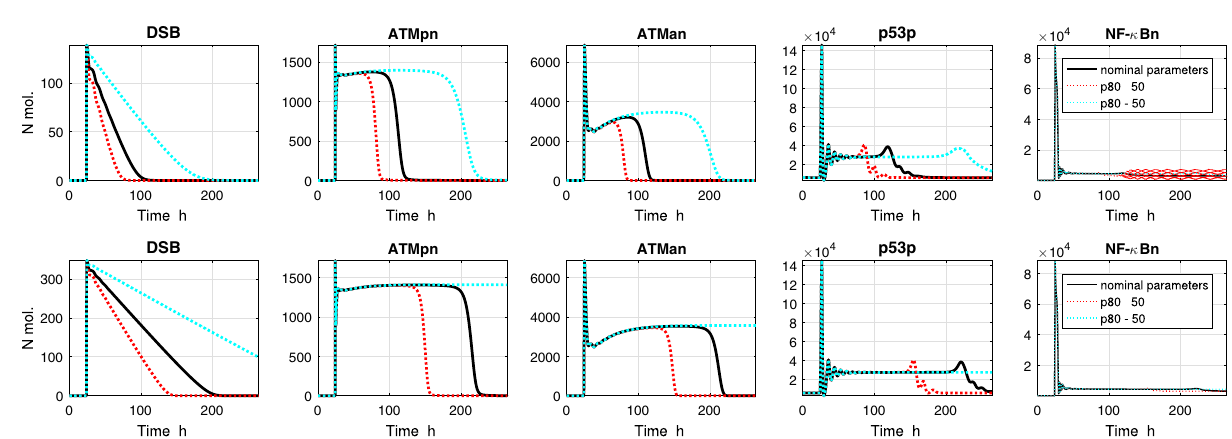
Figure 6. Impact of increasing/decreasing the value of the parameter mc 1 (par. No. 80) on the model’s response. Simulation was performed with two input signals: (TOP PANELS) 10 ng/ml TNF and 4 Gy IR; (BOTTOM PANELS) 10 ng/ml TNF and 10 Gy IR. TNF stimulation is constant during the simulation, IR radiation is turned on after 24 h simulation for 1